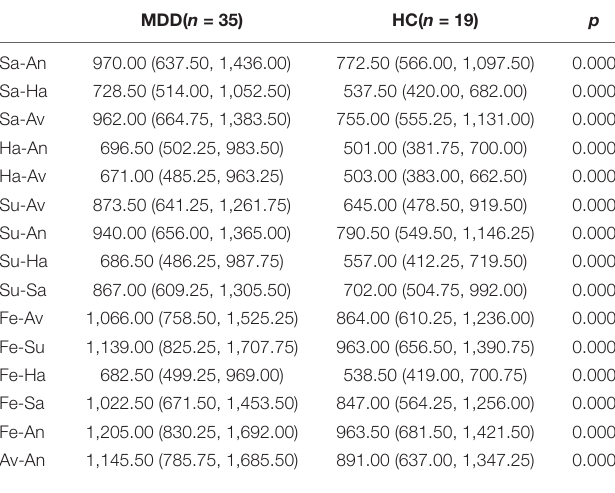
TABLE 3 | Facial expression recognition response time of MDD and HC